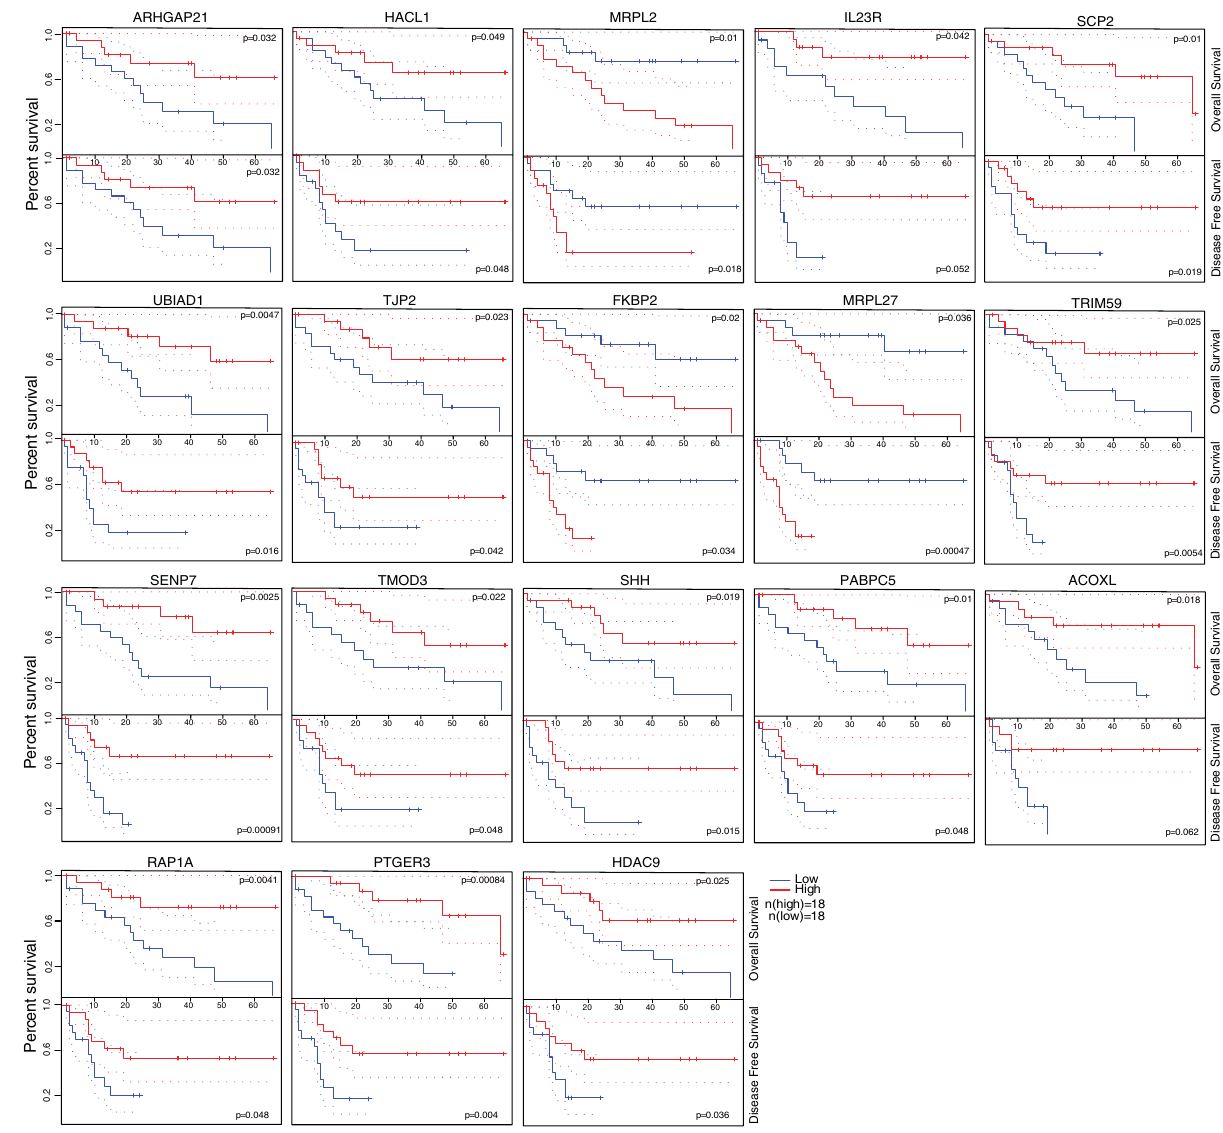
Figure 5. Survival analysis of significantly dysregulated hub genes based on TCGA data. Survival time is recorded in